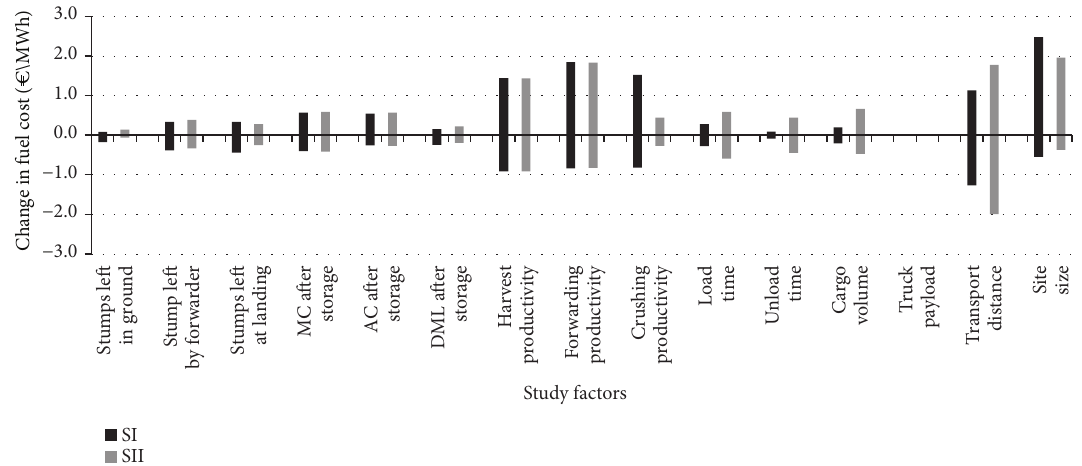
Figure 3: Effects on fuel cost (C/MWh) of individually changing one factor at a time from its 0-level to its low and high levels.